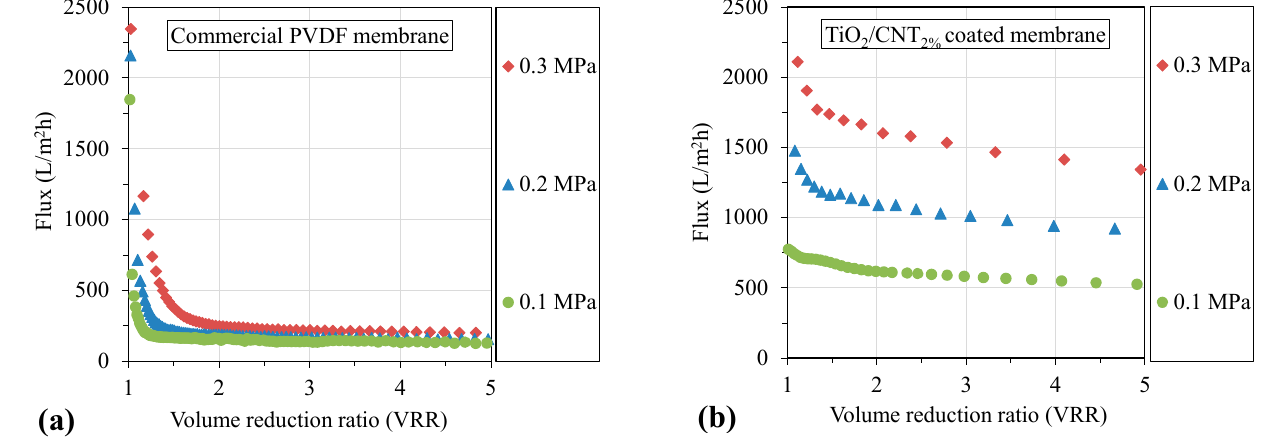
Figure 5. Effects of the transmembrane pressure on fluxes measured during the filtration of oil emulsions with the commercial membrane ( a ) and the TiO 2 /CNT 2% nanocomposite-modified membrane ( b ).